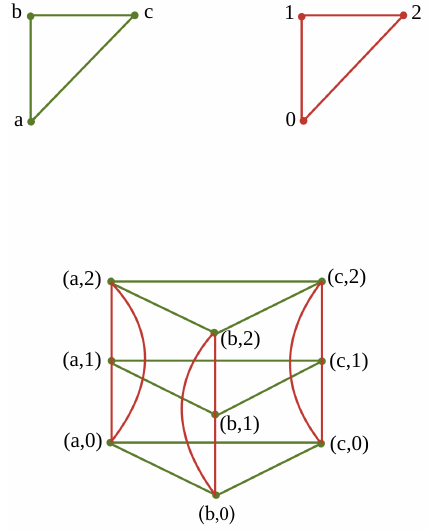
Figure 5. Cartesian product of SBGs G and G (cid:48)